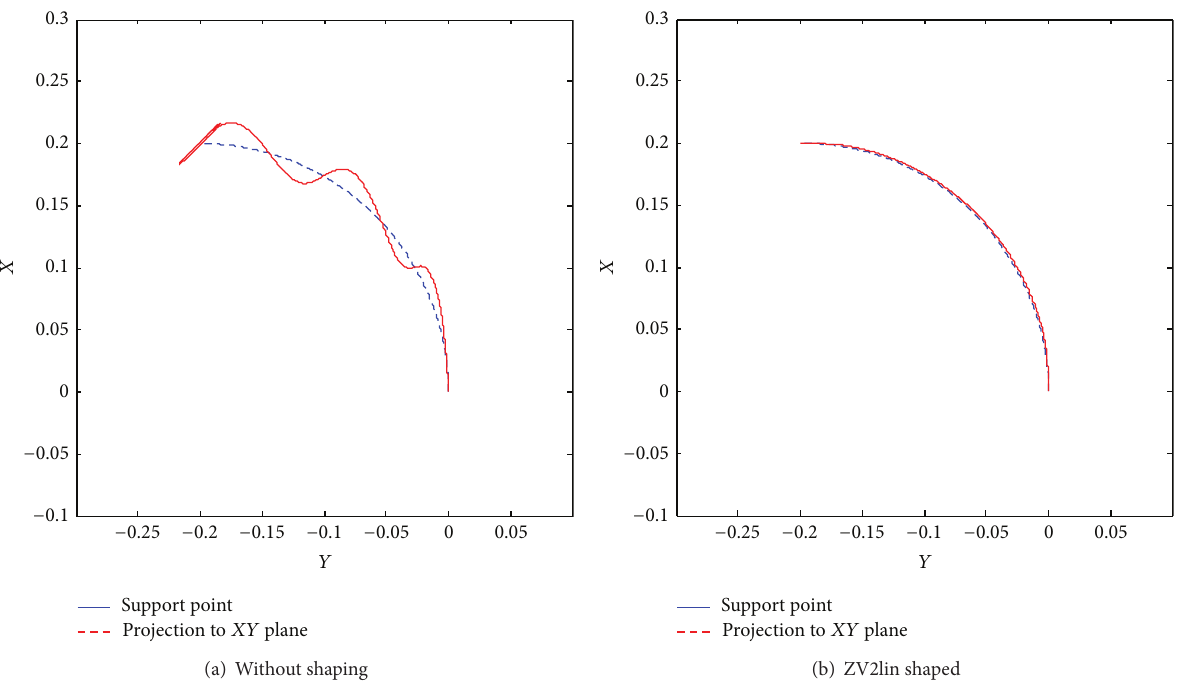
Figure 11: Pendulum position in XY plane of circular motion for (a) without shaping (b) with